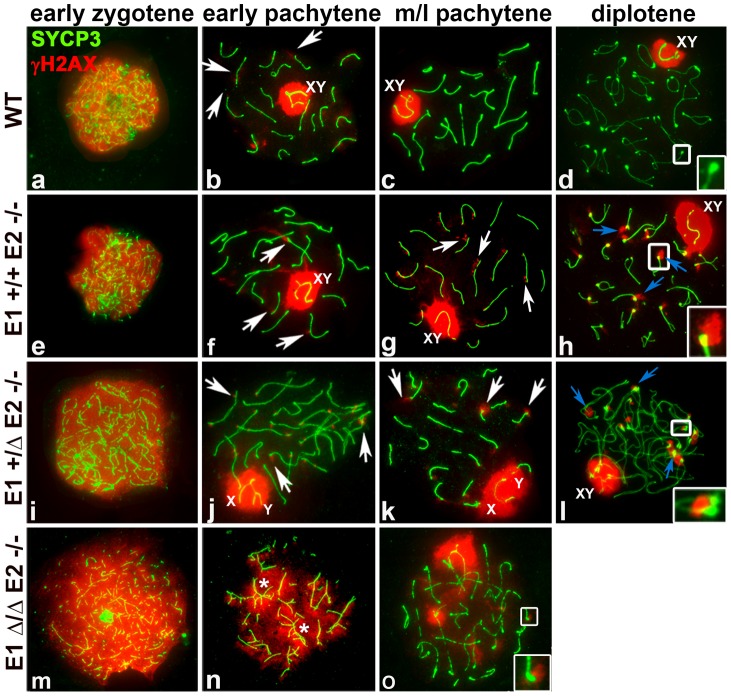
E2-deficient spermatocytes have unrepaired DSBs that are increased by depletion of E1.Chromosome spreads from adult WT (a–d), E1+/+E2−/− (e–h), E1+/ΔE2−/− (i–l) and E1Δ/ΔE2−/− spermatocytes (m–o) immunostained for γH2AX (red) and SYCP3 (green). Insets represent the area outlined. (a–d) γH2AX pattern in WT prophase I. (b) γH2AX localizes in the sex chromosomes and as foci in the chromatin adjacent to the SC in autosomes (white arrows). Telomeres in WT diplotene spermatocytes are devoid of γH2AX (d, white inset). (e–h) E1+/+E2−/− spermatocytes; (i–l) E1+/ΔE2−/− spermatocytes. γH2AX persists as foci in autosomes (g,j, white arrows) and in telomeres (g,k white arrows; h,l, blue arrows, insets). (m–o) γH2AX signal is distributed throughout the chromatin in E1Δ/ΔE2−/− early pachytene spermatocytes, primarily in unsynapsed chromosomes and chromosome associations (n, asterisks). The few spermatocytes observed at mid-pachytene displayed telomeric γH2AX foci (o, white inset).